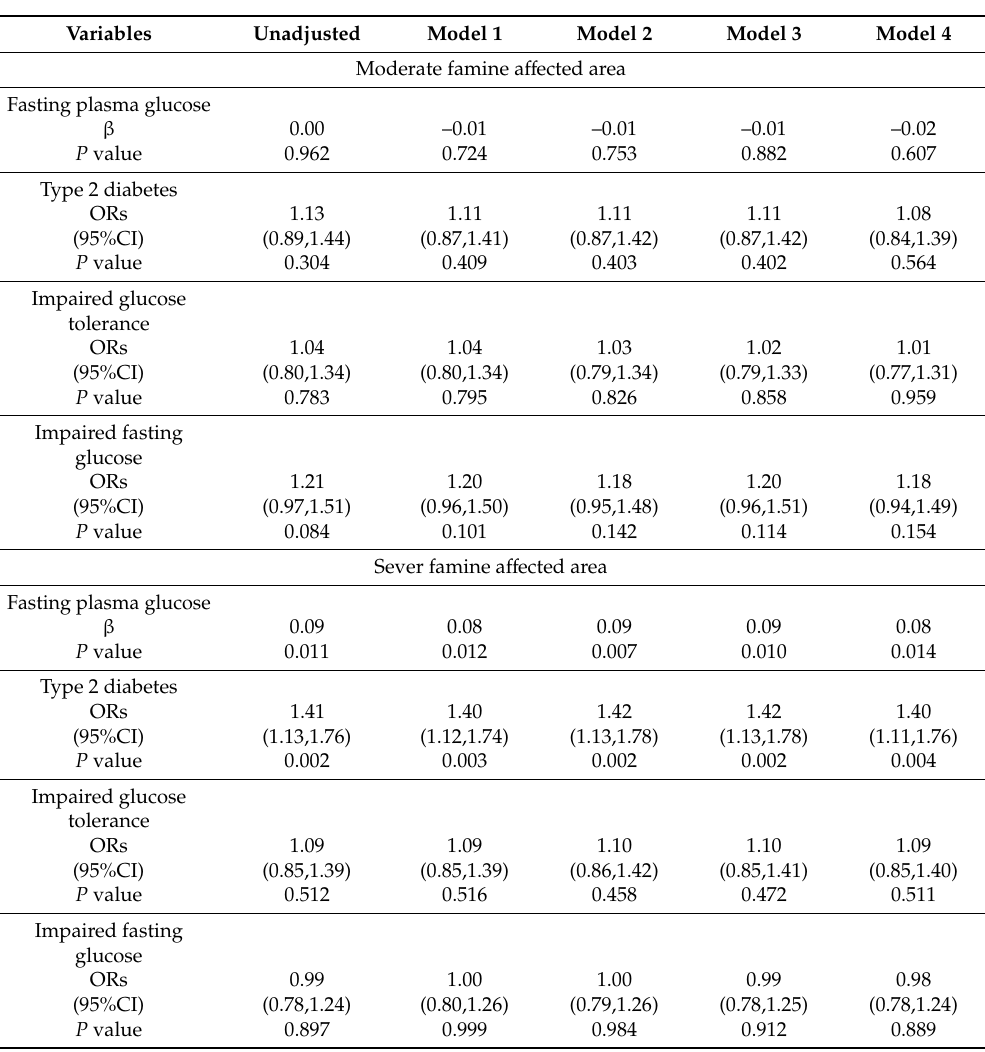
Table 3. Associations between fetal famine exposure and the risk of dysglycemia in adulthood in di ff erent